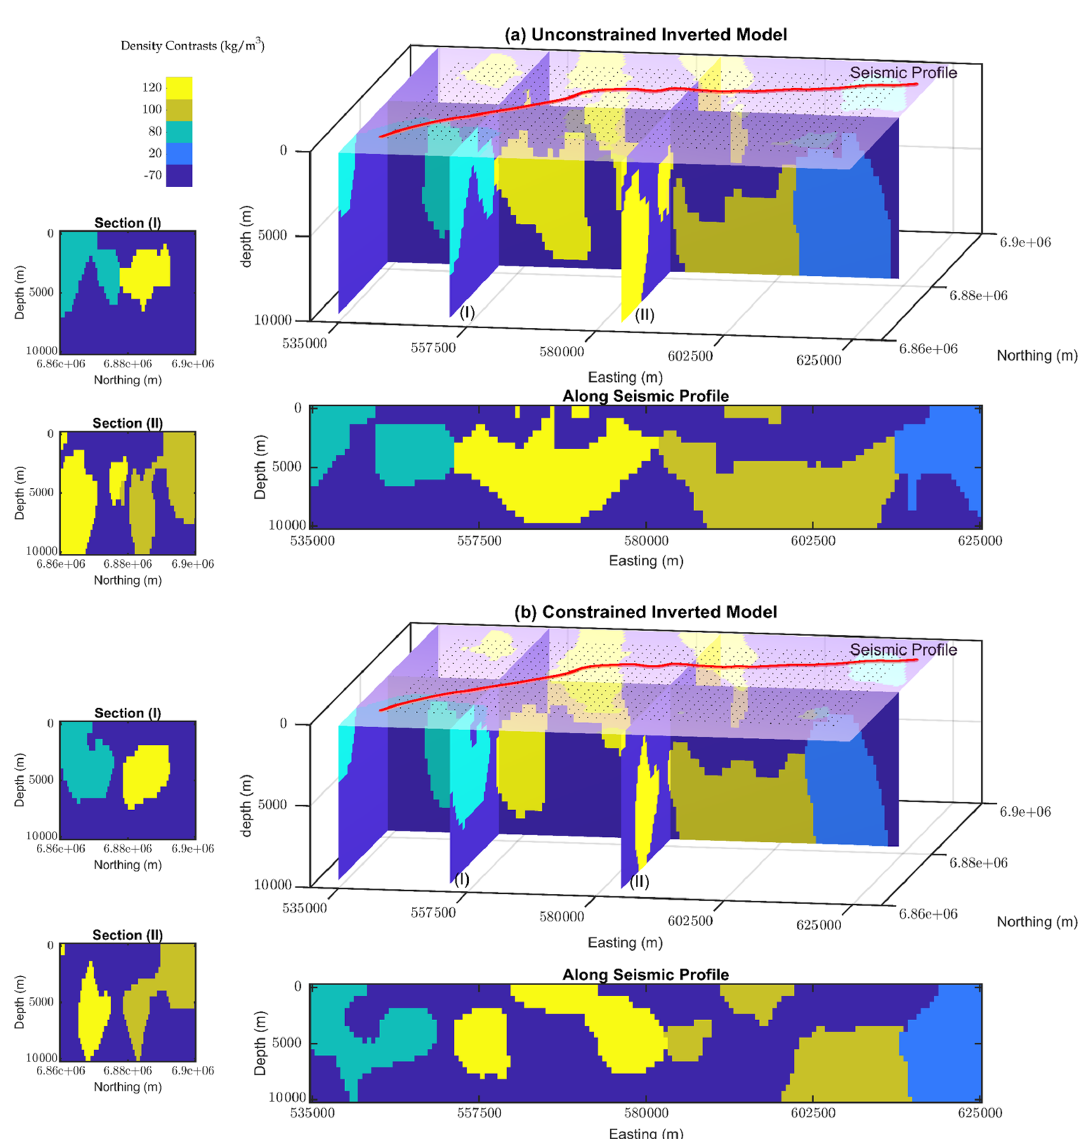
Figure 12. Different views of the final inverted models from the unconstrained and constrained 3D gravity level set inversion of Yamarna Terrane, respectively. Black dots at the surface level represent the interpolated gravity